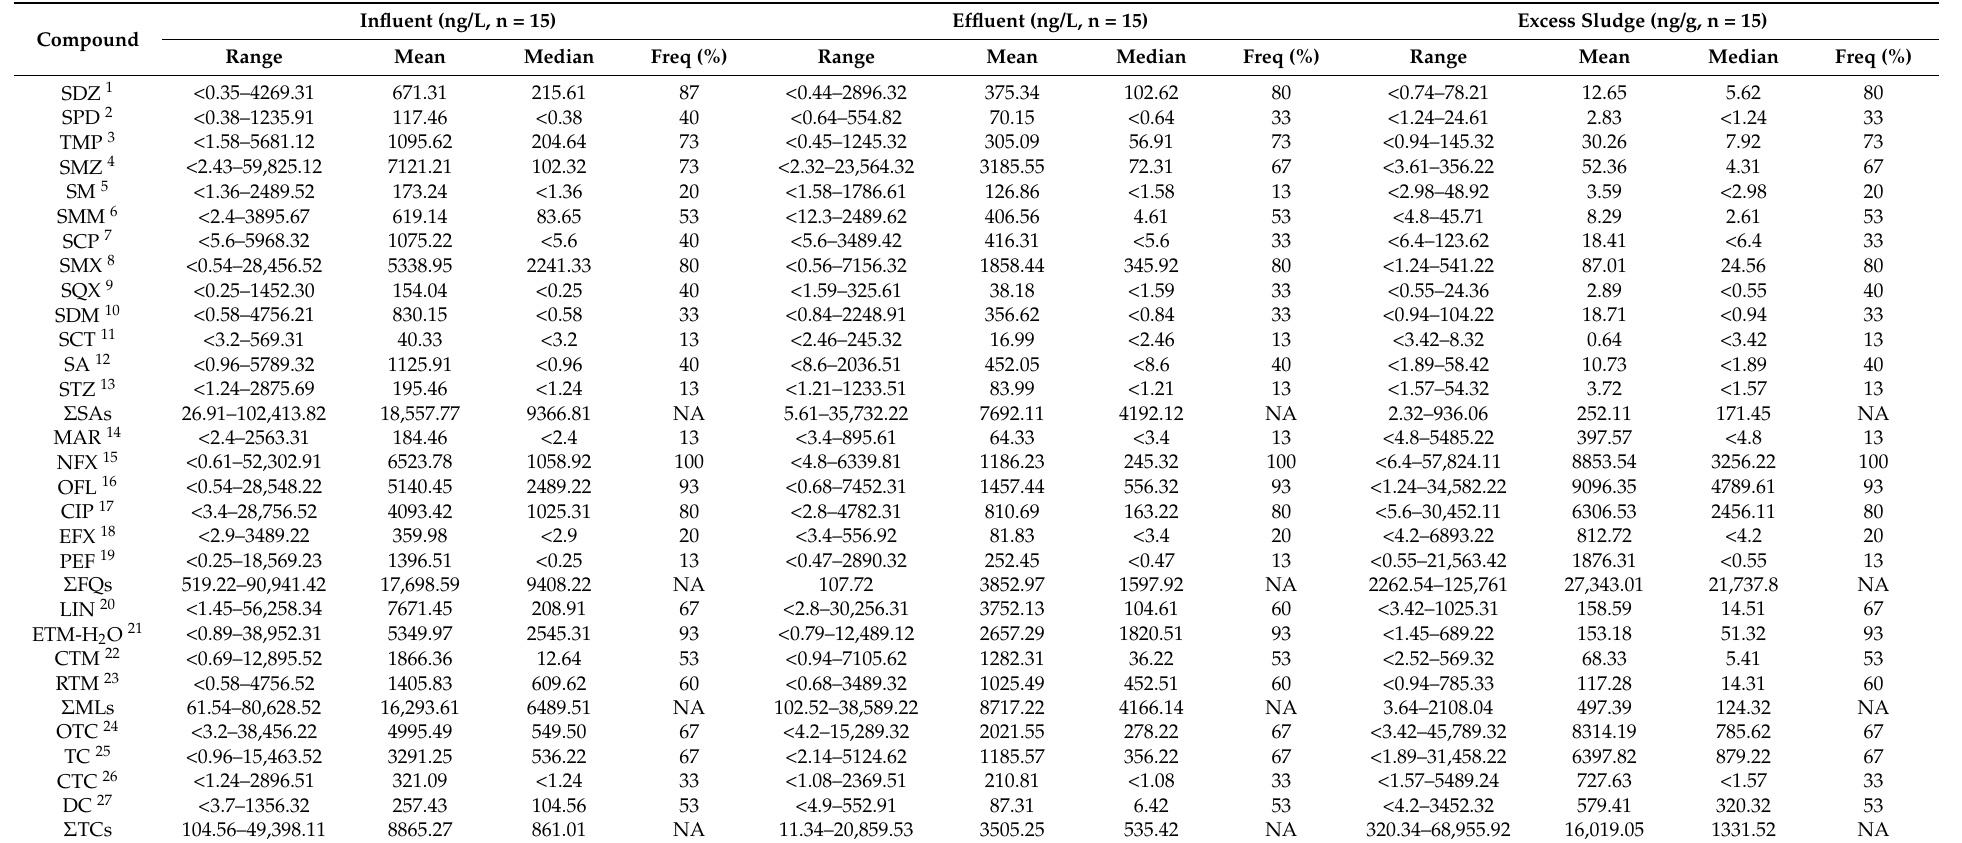
Table 2. Antibiotic concentrations in the influent, effluent, and excess sludge of 15 Chinese pharmaceutical